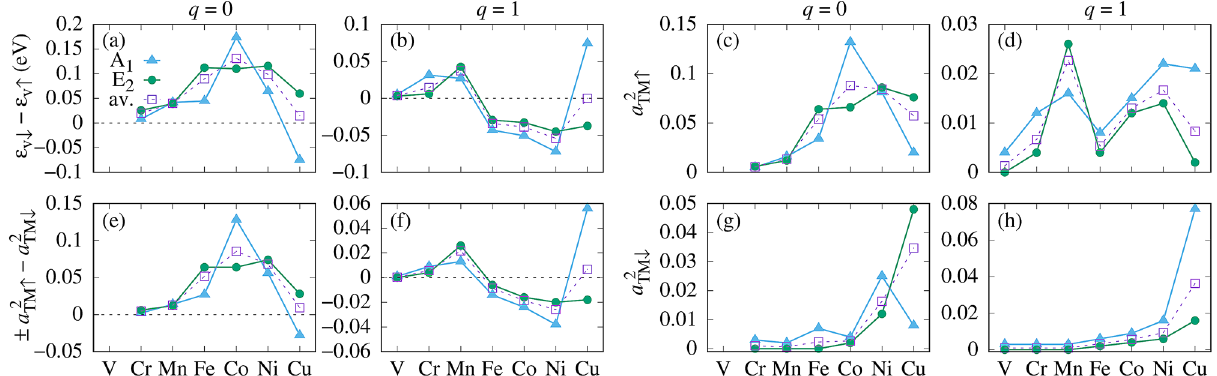
Figure 6. ( a , b ) The spin splitting of the singlet A 1 and the doublet E 2 hole states together with its weighted average, ( c , d ) and ( g , h ) the appropriate decomposition coefficients a 2 TM ↑ and a 2 TM ↓ of the VBM functions and ( e , f ) their combination ± a 2 TM ↑ − a 2 TM ↓ , see details in the text. Charge states q are indicated on the